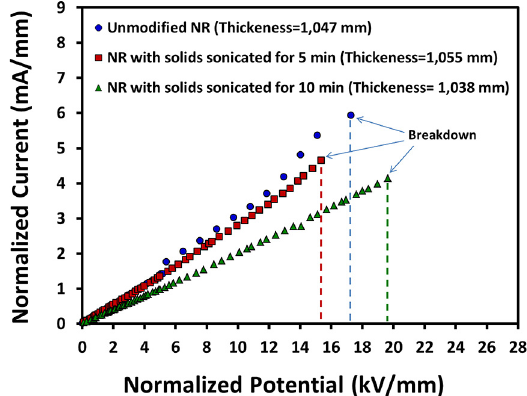
Figure 8. AC polarisation curves obtained from breakdown strength measurements for vulcanized rubber specimens with ZnO and TiO particles